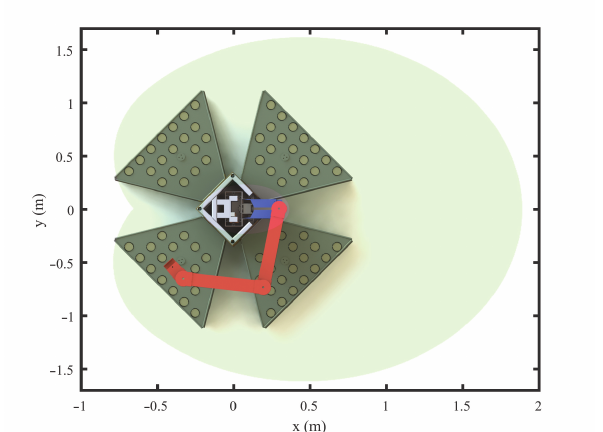
Figure 6. The horizontal workspace of the robot arm using the selected values of l 0 , l 1 , l 2 , and l 3 . The green area can be reached with at least one tool orientation.